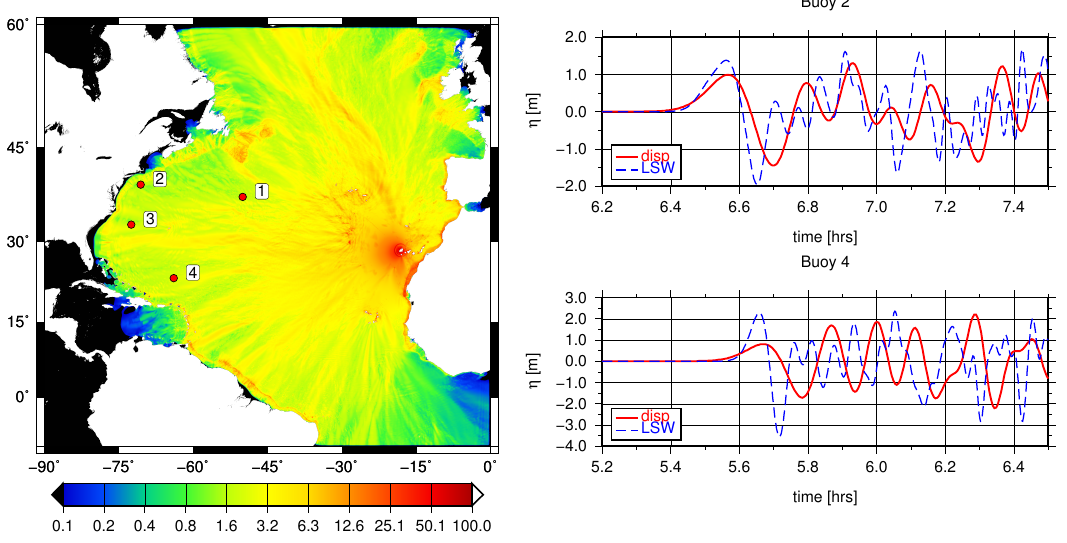
Fig. 14. The La Palma tsunami. Left panel: maximum wave elevation and position of buoys. Right panels: time series at two buoy locations. it is noteworthy that Lynett et al. (2003) reported that even though dispersion had a crucial effect on the incident wave, the flooding was rather similar to the one obtained by a NLSW model. It is not clear whether this is circumstantial or a more general feature.